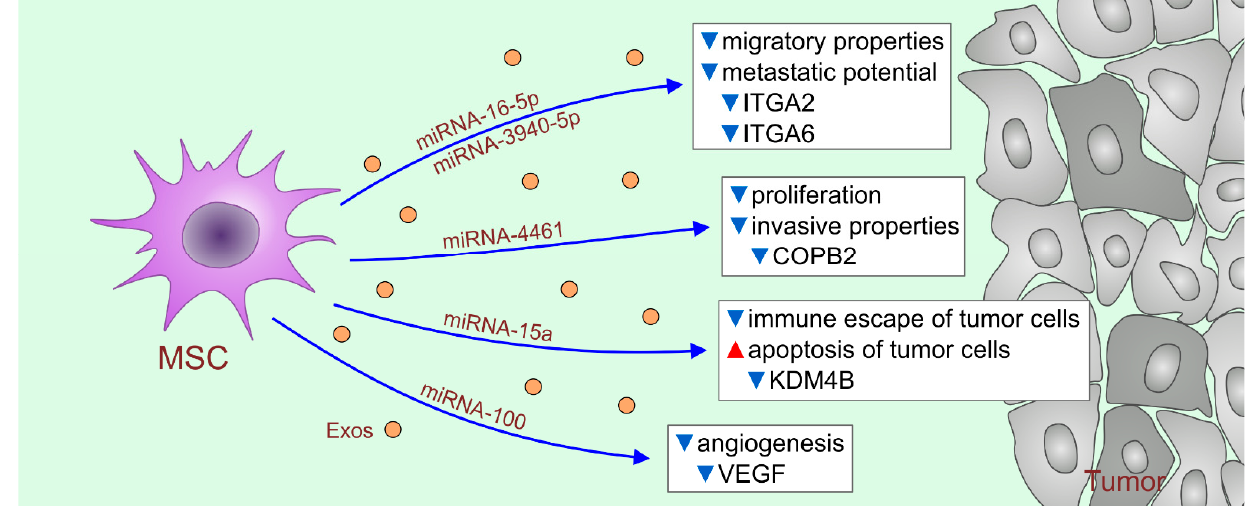
Figure 2. MSC-EVs as potentially new therapeutic agents in immunotherapy of malignant diseases. MSC-EVs deliver anti-tumorigenic miRNAs directly into tumor cells, altering their viability, proliferation rate and invasive characteristics. MSC-EV-sourced miRNA-16-5p and miRNA-3940-5p inhibited migratory properties and metastatic potential of tumor cells by down-regulating expression of integrins ITGA2 and ITGA6 on their membranes. MSC-EV-delivered miRNA-4461 suppressed proliferation and invasive properties of tumor cells by reducing expression of COPB2, which is essential for Golgi budding and vesicular trafficking. MSC-EVs carrying miRNA-15a inhibit the immune escape of tumor cells by regulating expression of HOXC4, which binds to the promoter sequence of PDL1, controlling its synthesis and membrane expression. MSC-derived miRNA-15a induces apoptosis of tumor cells by inhibiting activity of KDM4B which epigenetically regulates chromatin structure. The MSC-EV-delivered miRNA-100 down-regulates production of VEGF in cancer cells, preventing generation of new blood vessels in growing tumors. The red triangle represents increased and the blue triangles represent decreased activity.